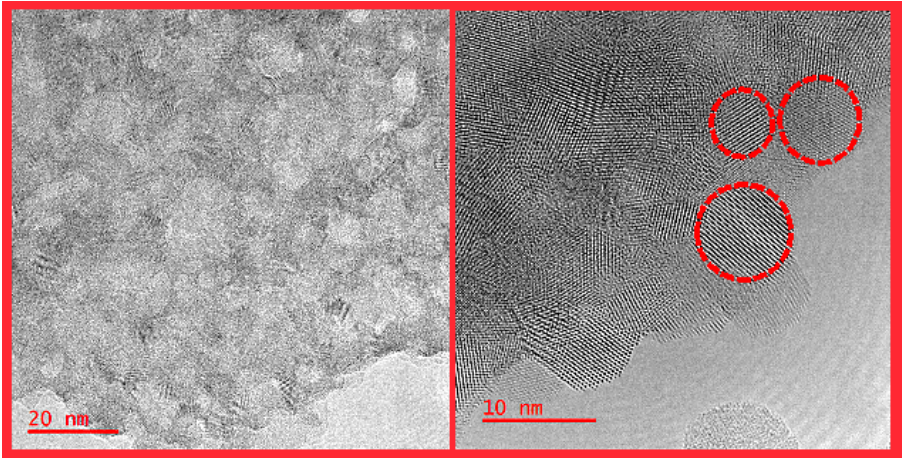
Figure 3. TEM/HRTEM images of the CZLPY powder sample at different magnifications.